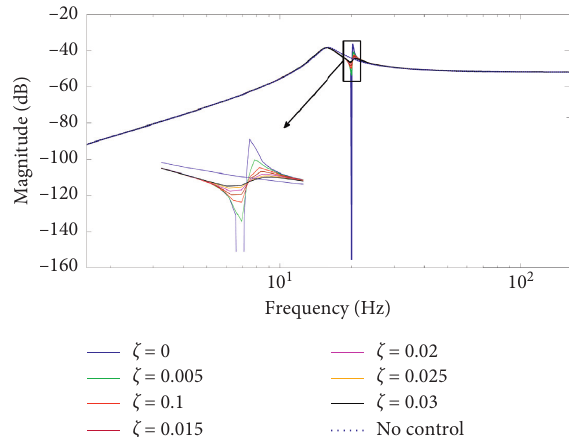
Figure 5: Logarithmic amplitude-frequency characteristic curves of the structure with and without the FATMD (varying ξ ).